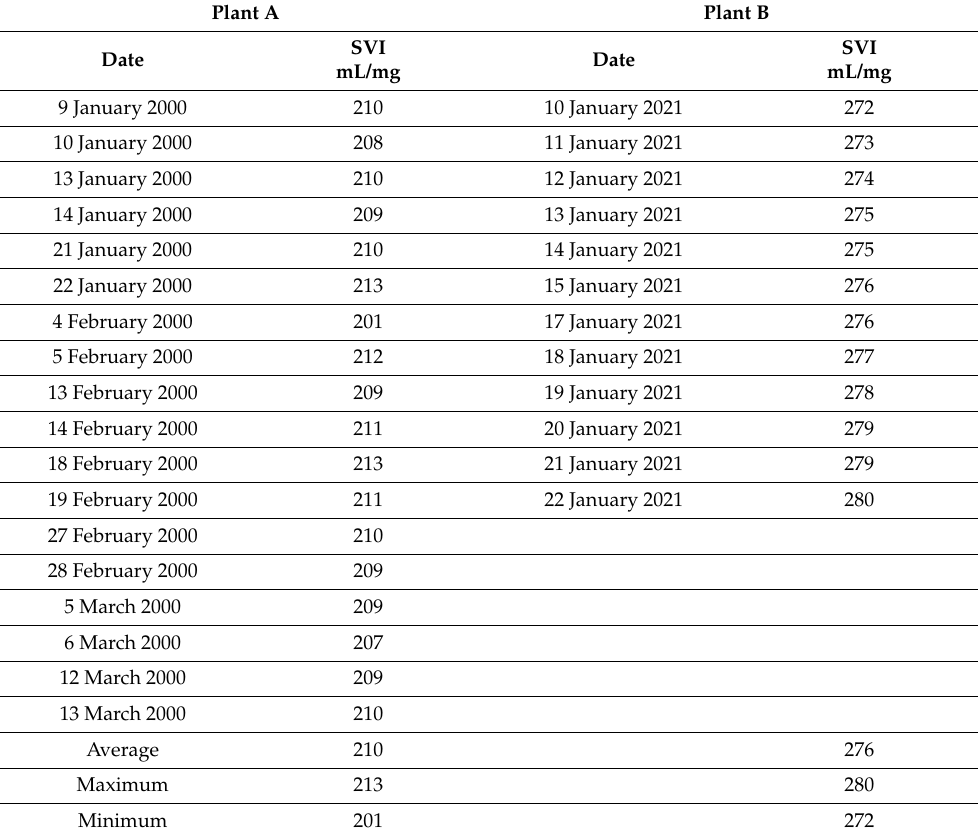
Table 9. SVI values for respective sampling day at plant A and B. Plant A Plant